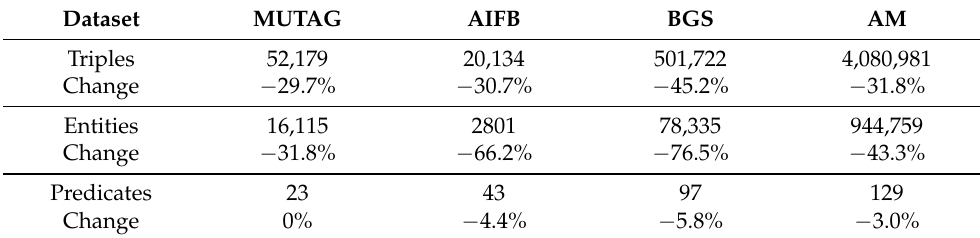
Table 3. Percent reduction in coarse graphs relative to base graphs at α = 0.5 and η =